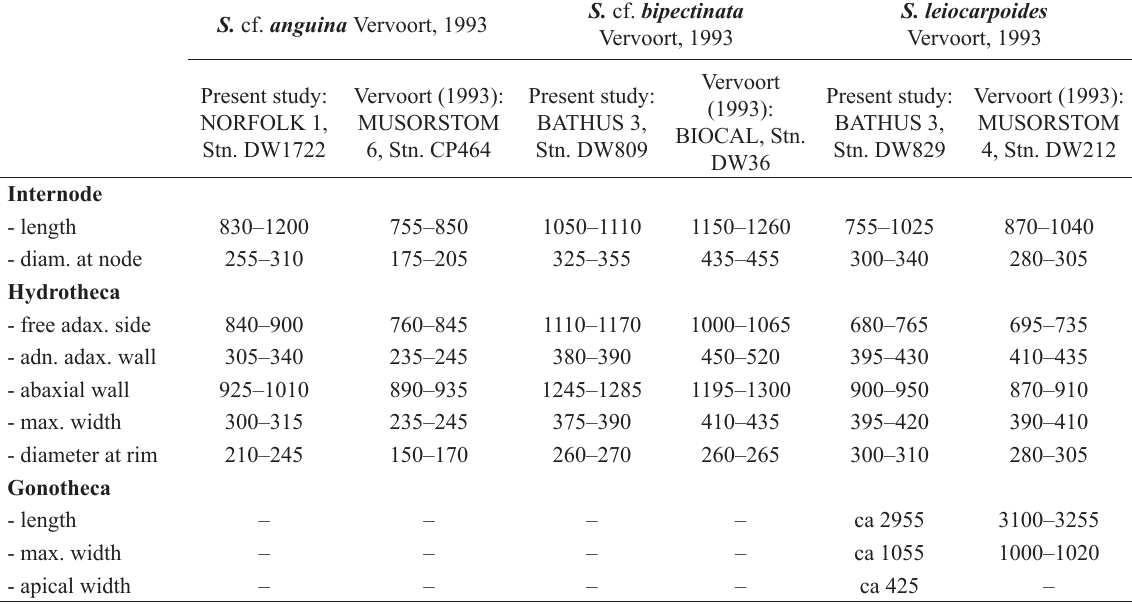
Table 5. Measurements (in µm) of Sertularella cf. anguina Vervoort, 1993, S . cf. bipectinata Vervoort, 1993, and S. leiocarpoides Vervoort, 1993, and comparisons with their respective holotypes (second column for each